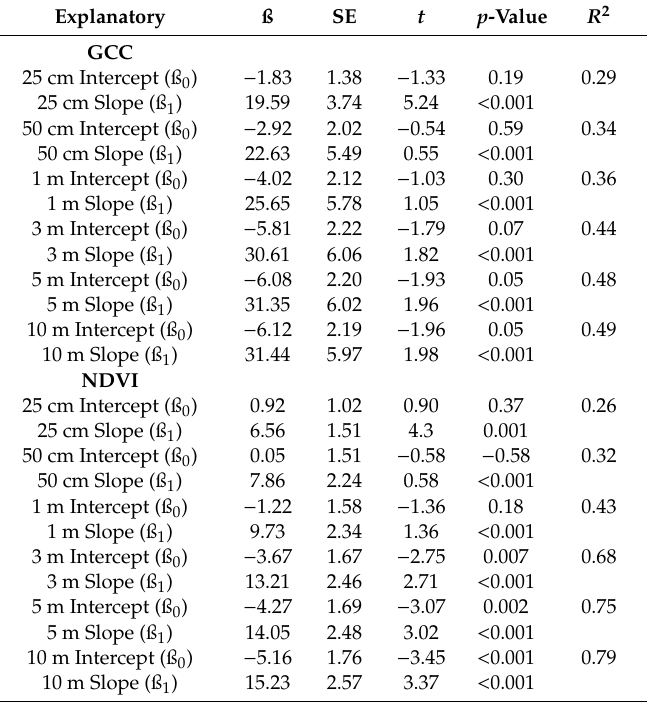
Table 4. Linear models testing how well log-transformed aboveground carbon biomass (C mass) is predicted by GCC and NDVI across increasing spatial resolutions. Aboveground carbon biomass includes live trees and tall deciduous shrubs. Vegetation index values were an aggregated mean extracted at an increasing bu ff er radius. For each model, we report estimates of the coe ffi cients (ß) for the y-intercept and slope, Standard Error (SE), the test statistic value ( t ), p -value, and adjusted R 2 . Statistical relationships are visualized in Figure 3.